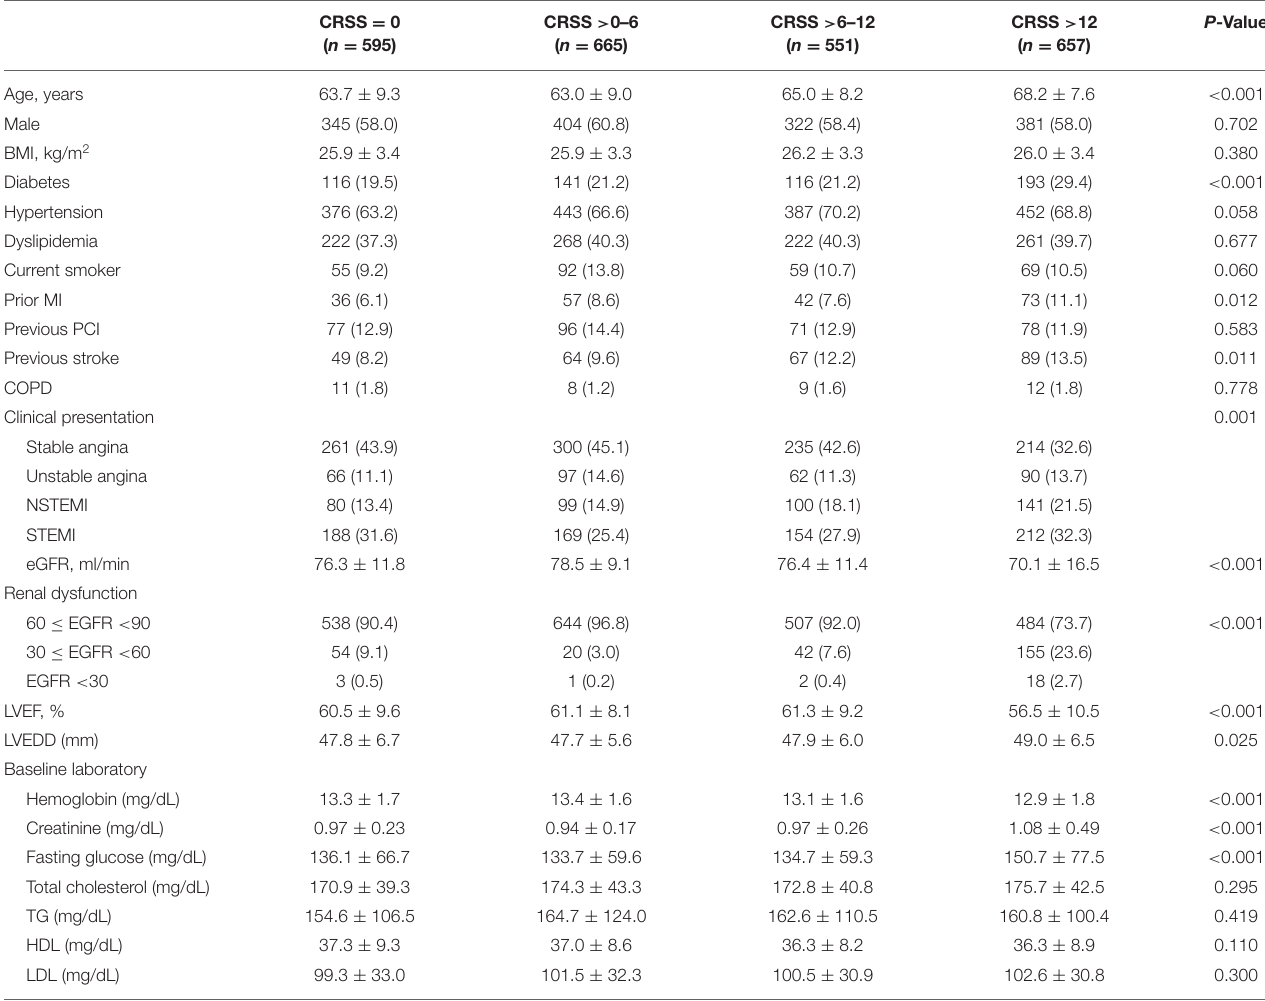
TABLE 1 | Baseline clinical